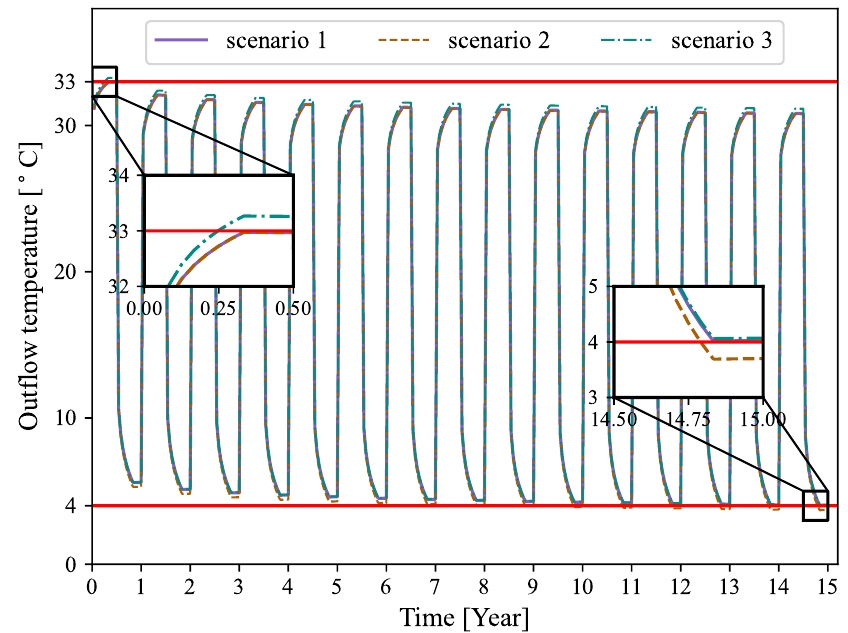
Figure 3. Comparison of the outlet temperature of MSBHE under three scenarios.